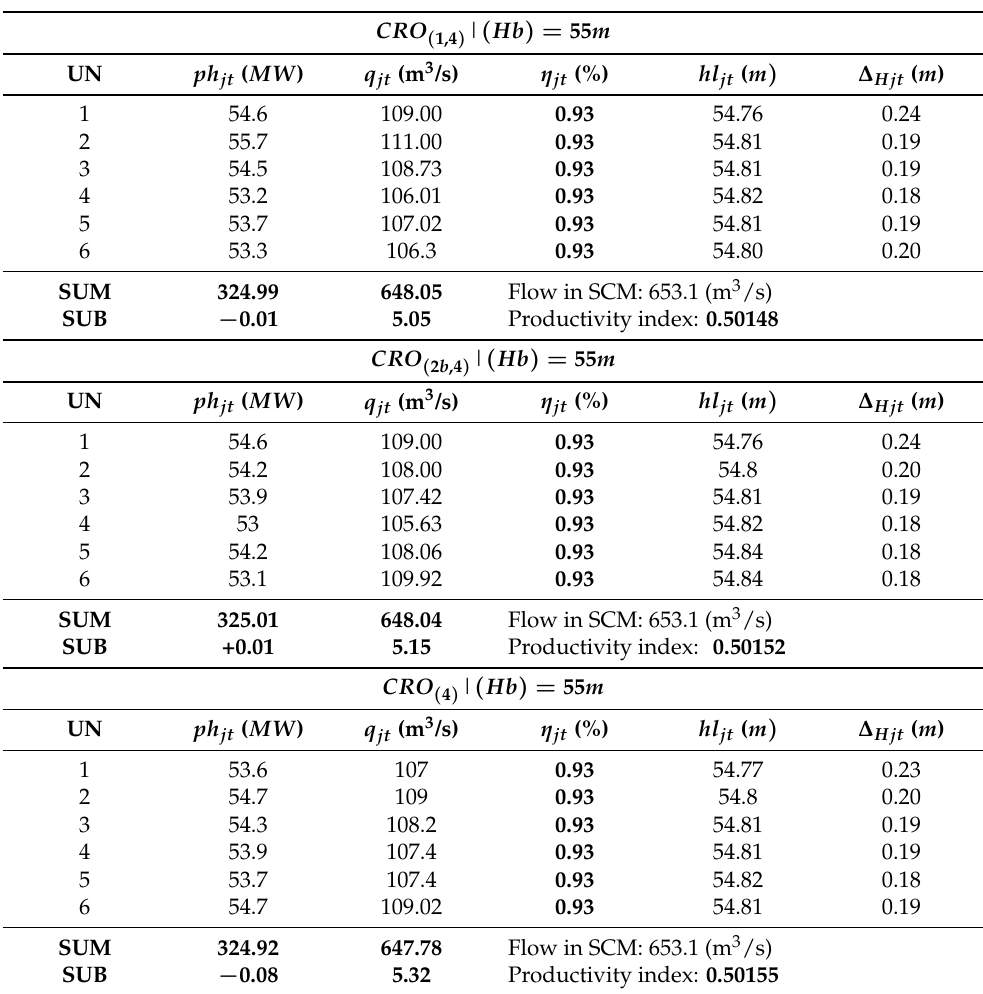
Table 3. General simulation report of 325 MW/h. The results in bold mean the maximum effi- ciency